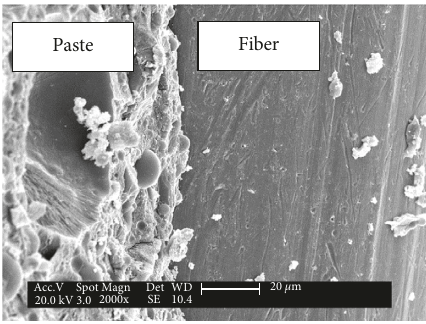
Figure 6: The bond between the fiber and the matrix in UHPC-2%.